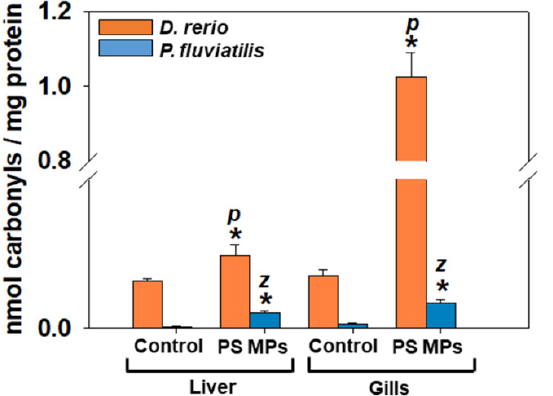
Figure 4. Protein carbonylation (mean ± SD nmol carbonyls mg − 1 protein) in liver and gills of Danio rerio ( n = 3 pools of 10 individuals) and Perca fluviatilis ( n = 6). The results were expressed as nmol carbonyl groups mg − 1 of protein. Mann–Whitney U test was employed to test for significance at p < 0.05 between all experimental groups. * denotes significant differences ( p < 0.05) compared to the control group ( n = 3 pools of 10 individuals and n = 6 for D. rerio and P. fluviatilis respectively), while z and p denote significant differences ( p < 0.05) between D. rerio and P. fluviatilis respectively.